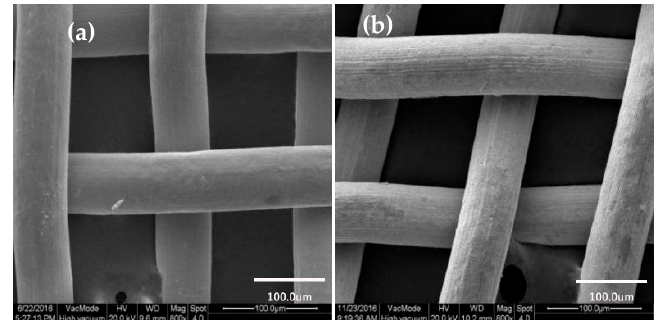
Figure 4. SEM image of copper mesh at 800×. ( a ) Surface morphology of untreated copper mesh; ( b ) Surface morphology of copper mesh after etching and oxidation.